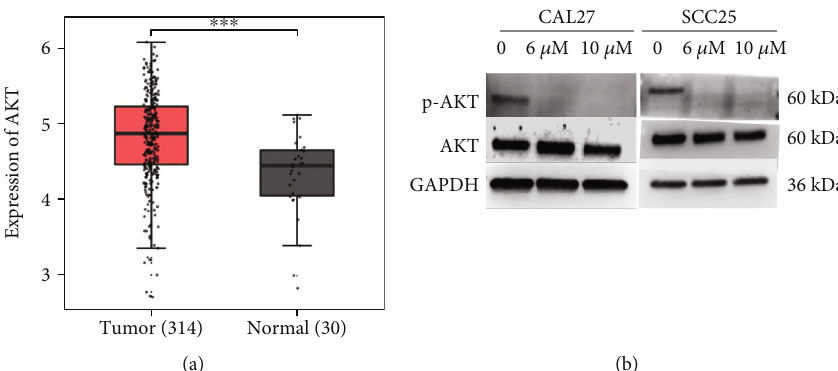
Figure 1: Assessment of AKT expression in oral cancer patients analyzed in TCGA datasets. (a) The expression levels of AKT in oral tumor tissues were higher than those in normal tissues analyzed in TCGA datasets. ∗∗∗ P < 0 : 001 as compared with the normal tissues. (b) Protein expression of AKT and p-AKT in CAL27 and SCC25 cells after MK2206 2HCl treatment for 24h by western